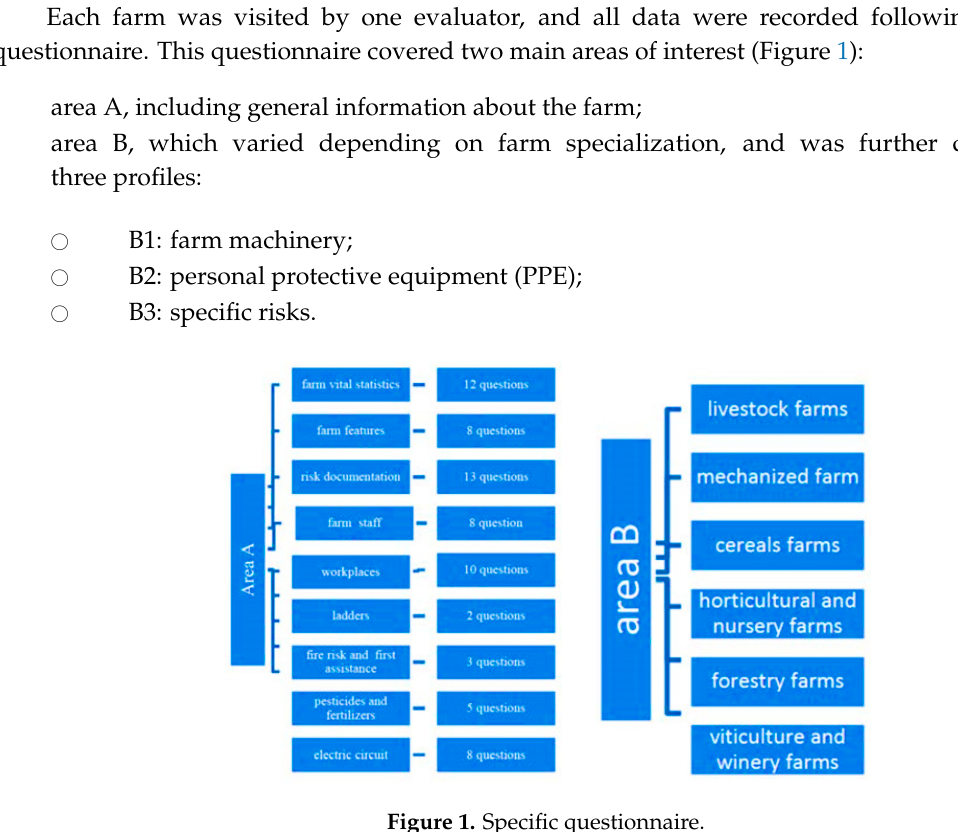
Figure 1. Specific questionnaire.